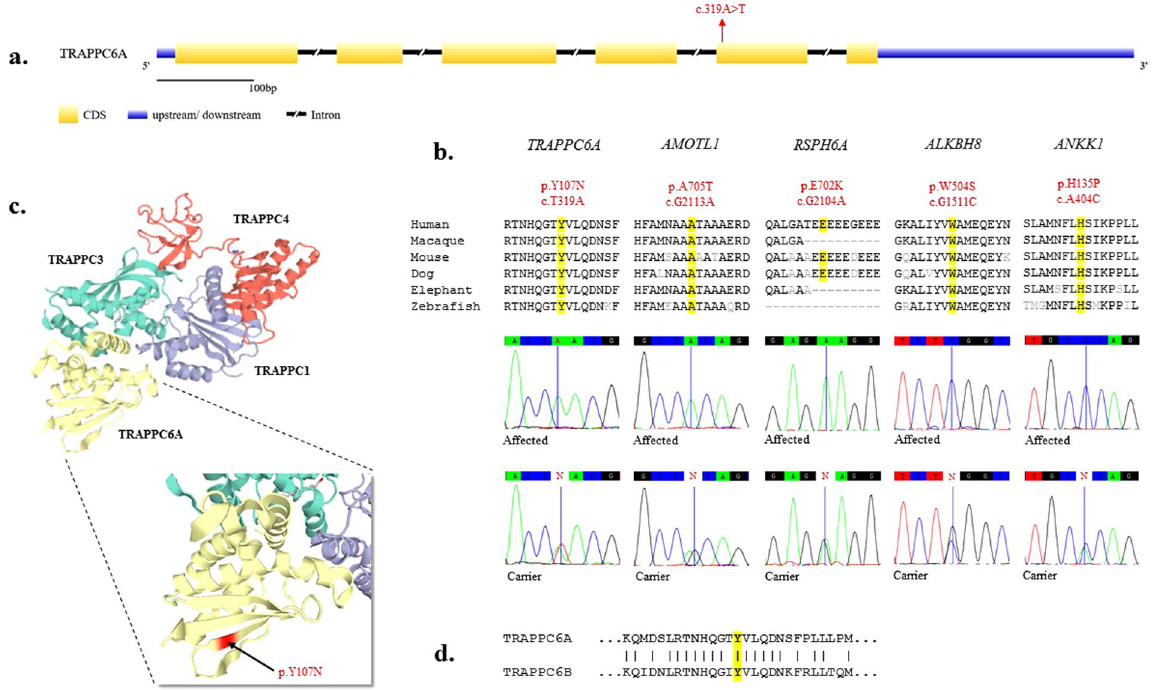
Figure 3. Gene structure, Sanger sequencing and protein modelling. ( a ) The structure of the TRAPPC6A gene is depicted showing intron-exon boundaries and the position of the mutation cT319A reported in this study. ( b ) Sanger sequencing of the five candidate genes ( TRAPPC6A , AMOTL1 , ANKK1 , RSPH6A , ALKBH8 ) confirms the mutations. Alignment of the primary sequence across various species indicates the relevant residues are highly conserved. ( c ) The crystal structure of the TRAPP3-TRAPP6A-TRAPP1-TRAPP4 subcomplex is shown. TRAPPC6A forms a heterodimer with TRAPPC3 and interacts with other subunits to form TRAPP I, TRAPP II and TRAPP III complexes. The amino acid change is shown in red. Protein structure was generated using SWISS-MODEL 33 . ( d ) Alignment of TRAPPC6A and TRAPPC6B sequences shows the tyrosine residue in TRAPPC6A (p.Y107N) is